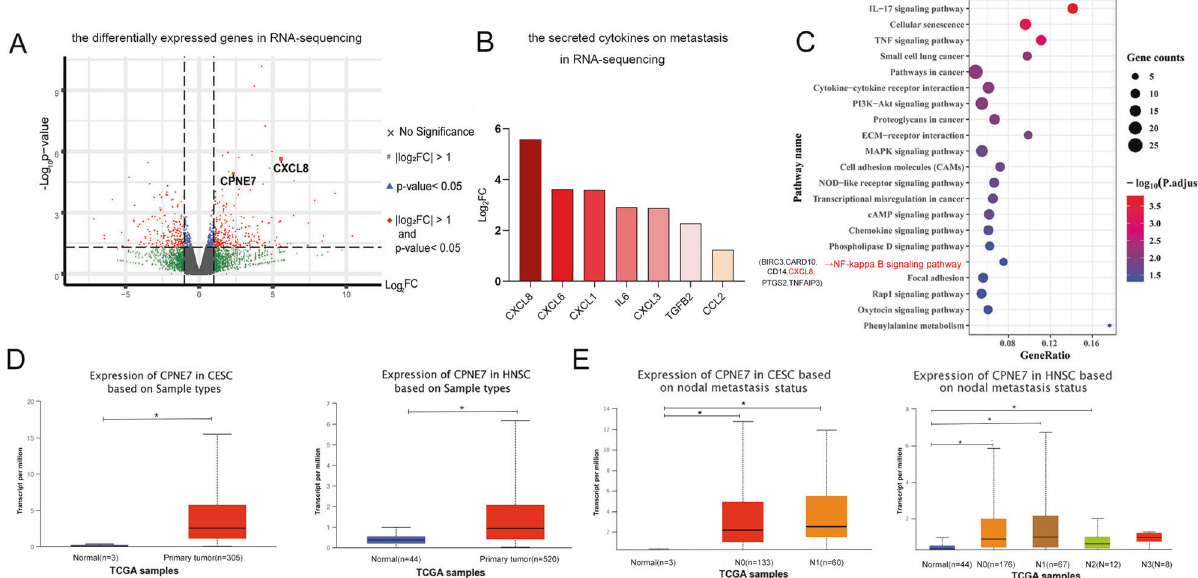
Fig. 2 CPNE7 regulates CXCL8 secretion through NF- κ B pathway in RNA-sequencing analysis. A volcano plot presenting all of the differentially expressed genes between OLK-MSCs and OSCC-MSCs ( ┃ fold change (FC) ┃ > 2, p - value<0.05). B The log 2 FC of the secreted cytokines on metastasis. C KEGG pathway analysis between OLK-MSCs and OSCC-MSCs ( p < 0.05). D Expression of CPNE7 in Cervical squamous cell carcinoma (CESC) and Head and Neck squamous cell carcinoma (HNSC) according to TCGA database. E Expression of CPNE7 in CESC and HNSC based on nodal metastasis status. N0: No regional lymph node metastasis. N1: Metastases in 1 to 3 axillary lymph nodes. N2: Metastases in 4 to 9 axillary lymph nodes. N3: Metastases in 10 or more axillary lymph nodes. * p <